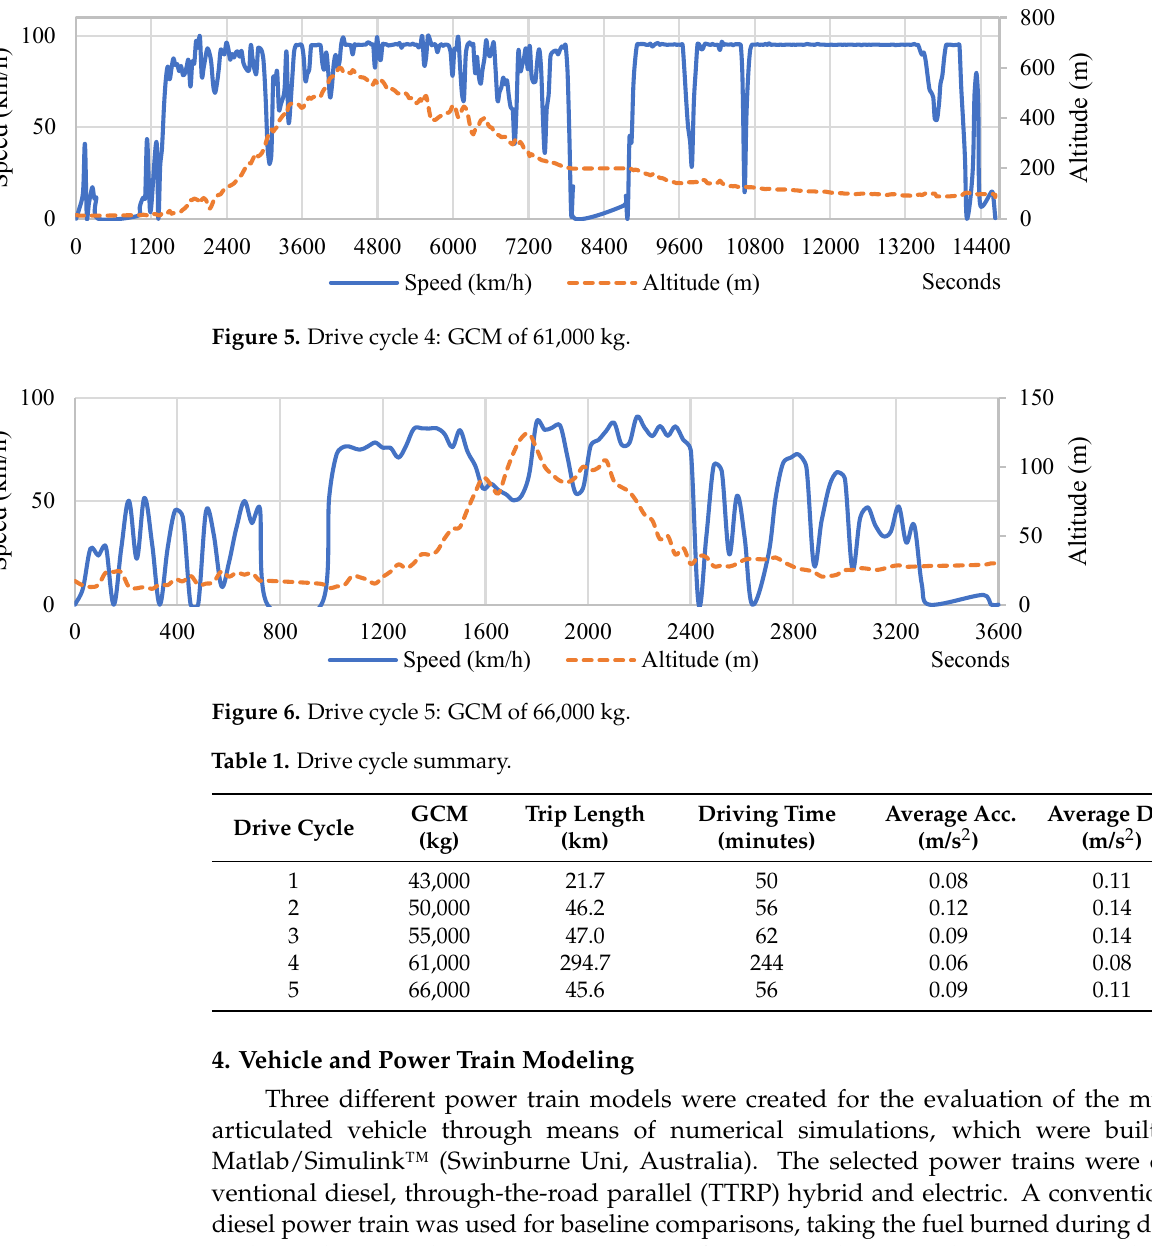
Figure 4. Drive cycle 3: GCM of 55,000 kg.